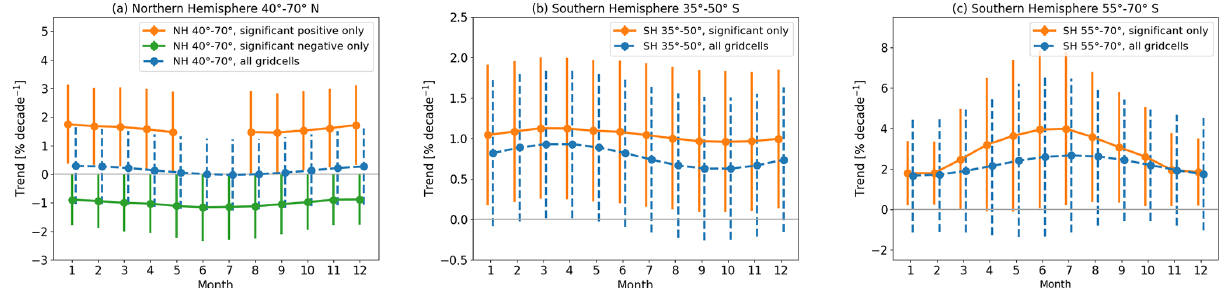
Figure 7. Total ozone trend as a function of month for three different latitude bands: (a) Northern Hemisphere 40–70 ◦ N, (b) Southern Hemisphere 35–50 ◦ S, and (c) Southern Hemisphere 55–70 ◦ S.